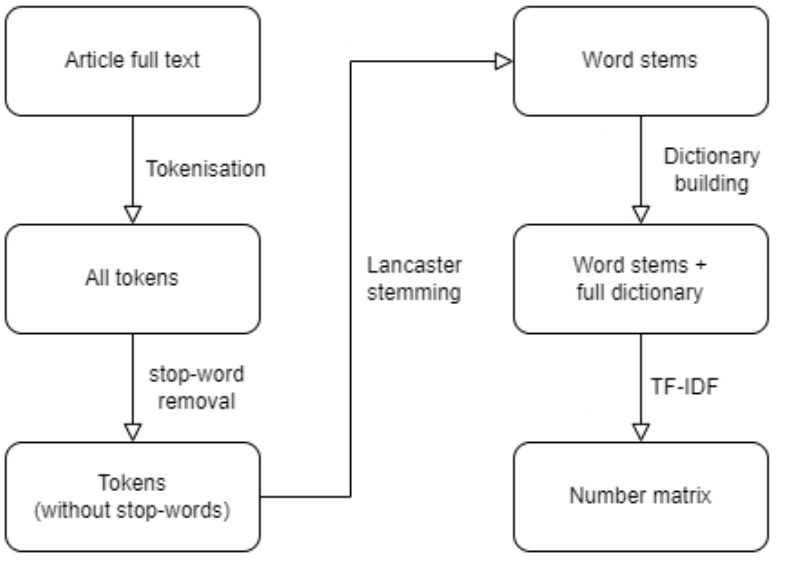
Figure 4. Diagram of input processing.